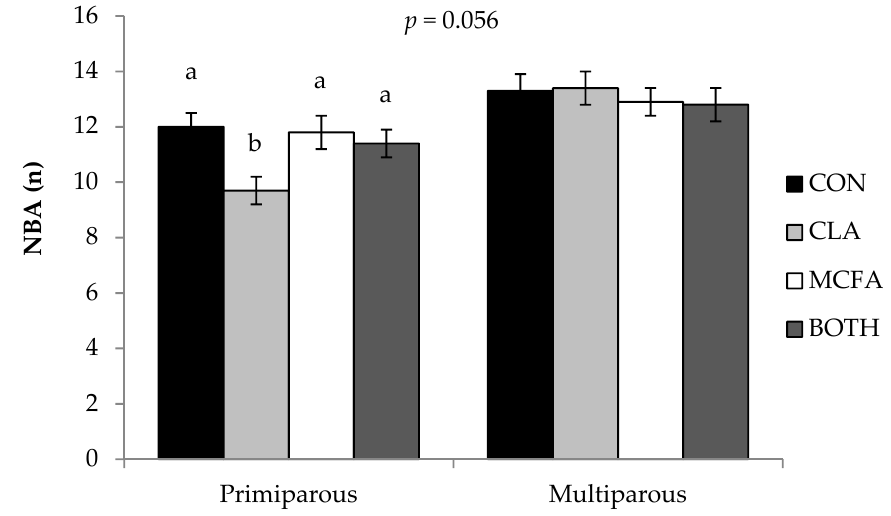
Figure 1. Treatment comparisons in number of piglets born alive (NBA) showing the interaction between dam parity (primiparous versus multiparous) and diet. ab Different superscripts denote values within dam parity group that are significantly different ( p < 0.05).